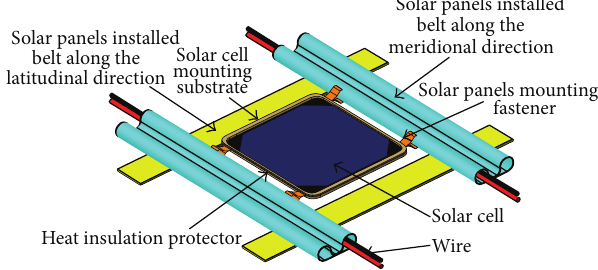
Figure 1: “Fish scale” design scheme for rigid solar cell module (single piece as shown).